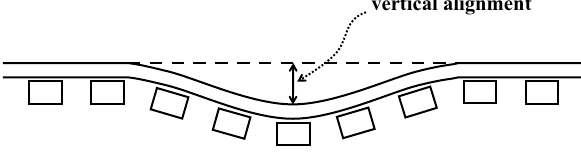
Figure 1. Vertical alignment.